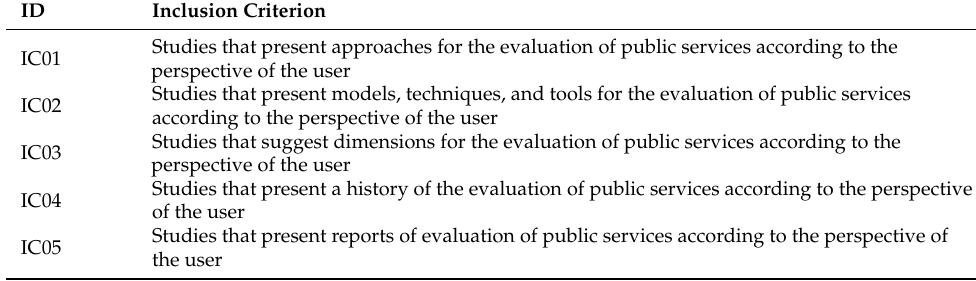
Table 3. Inclusion criteria.